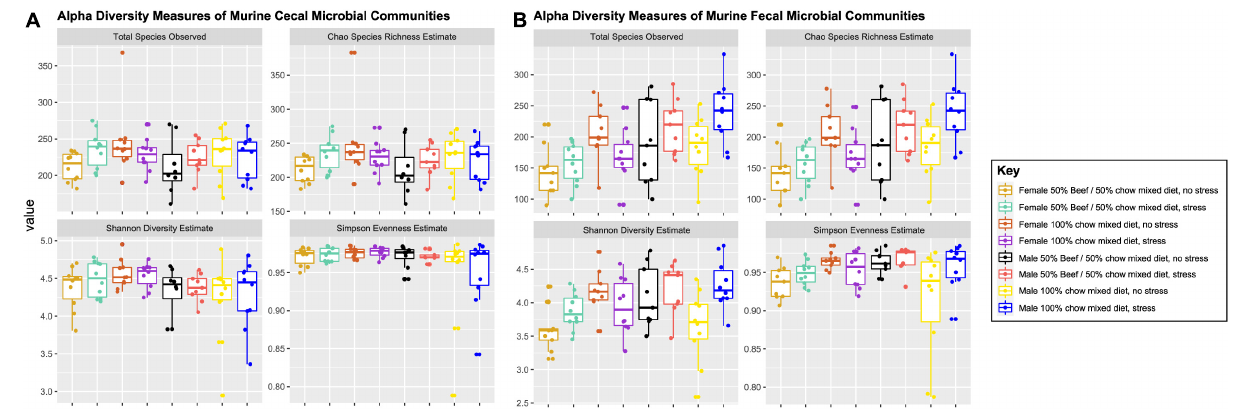
FIGURE 1 | Measures of alpha-diversity indices of cecal (A) and fecal (B) murine bacterial communities visualized for every combination of the fixed effects diet, sex and stress. Stress encompassed a chronic alternating forced swim and restraint stress paradigm as described in section “Materials and Methods.” Error bars 1.5X the 75th (upper) and 25th (lower) percentile. Significance of main effects and interactions were tested using the models described in the statistics section (Eqs 1 and 2) and are listed in Supplementary Table 3 .